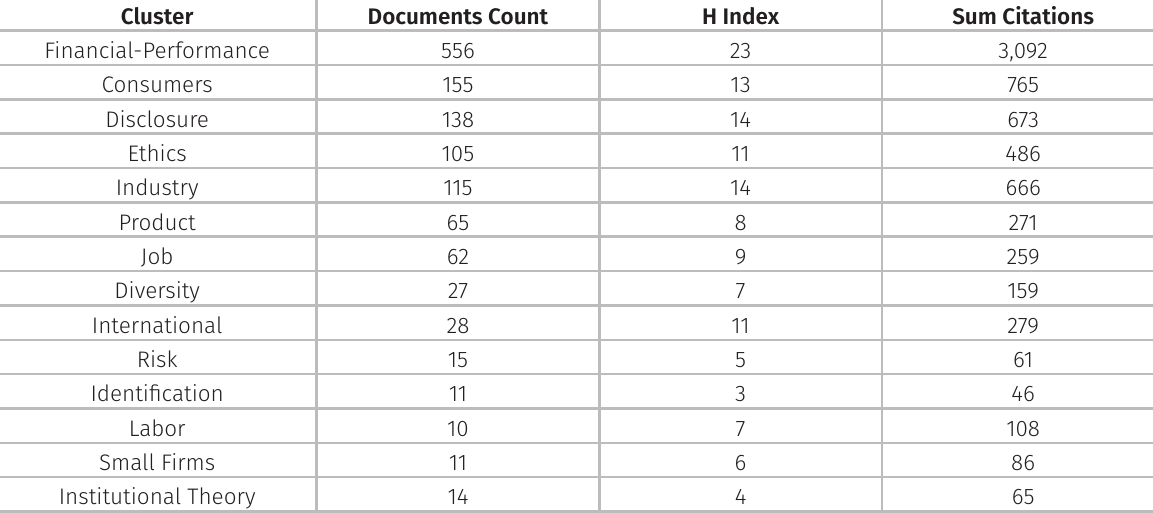
Table VIII. Performance of the themes in the 2015–2017